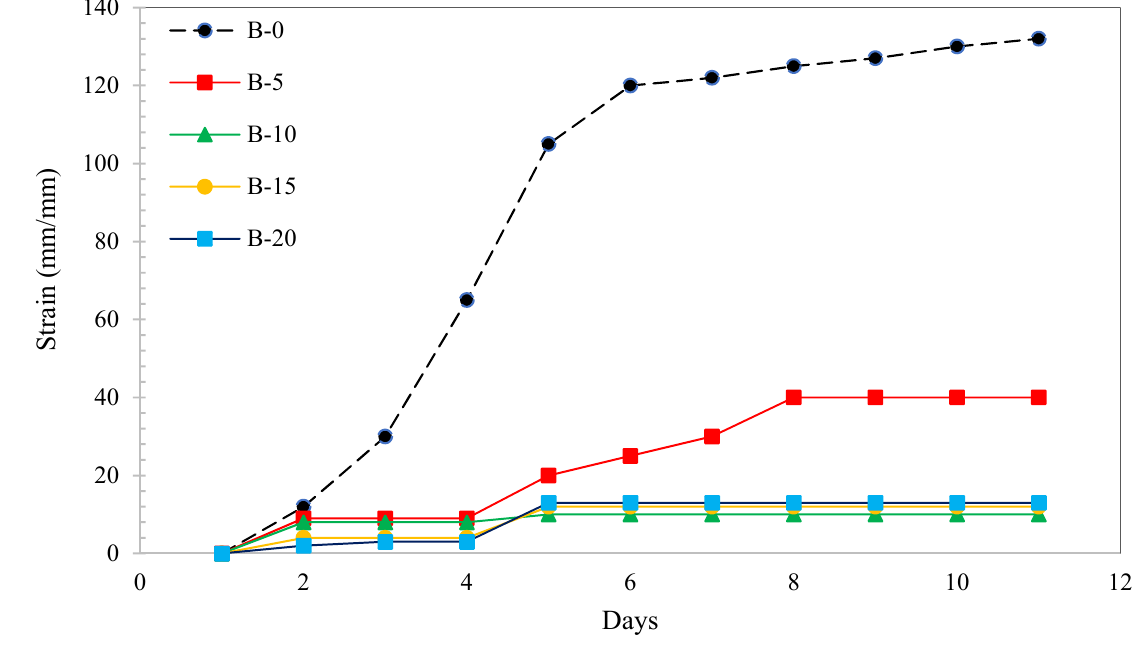
Figure 16. Dry shrinkage of concrete [71].